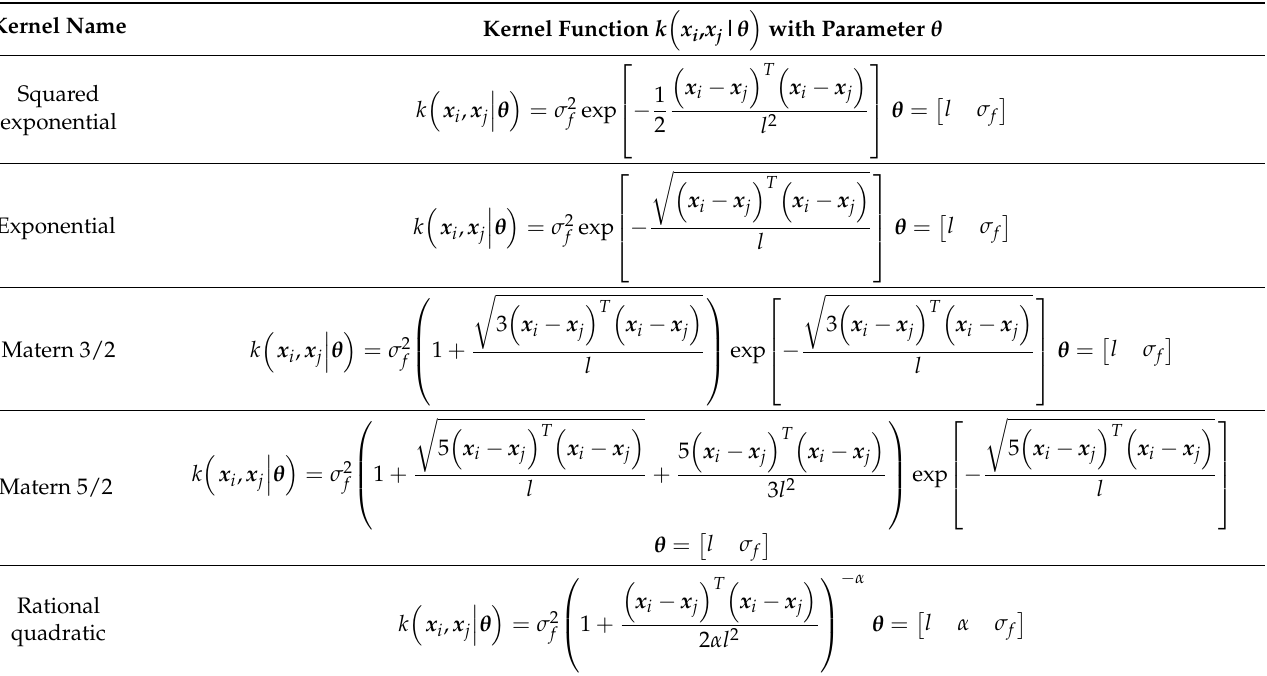
Table 1. Conventional kernel functions and corresponding parameters